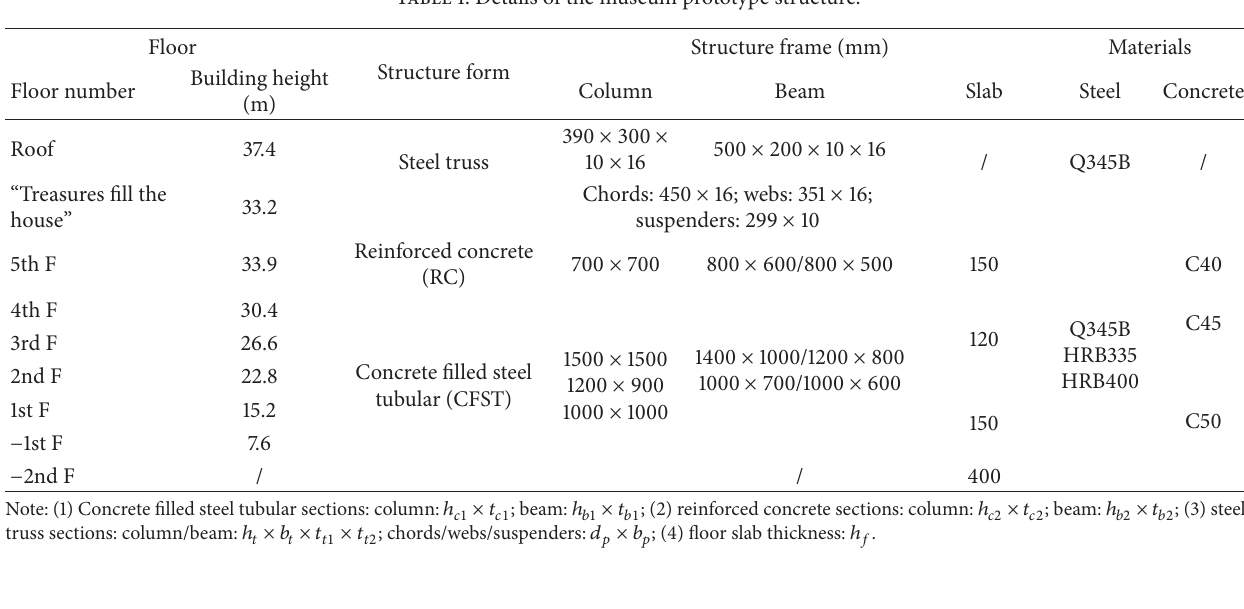
Table 1: Details of the museum prototype structure.